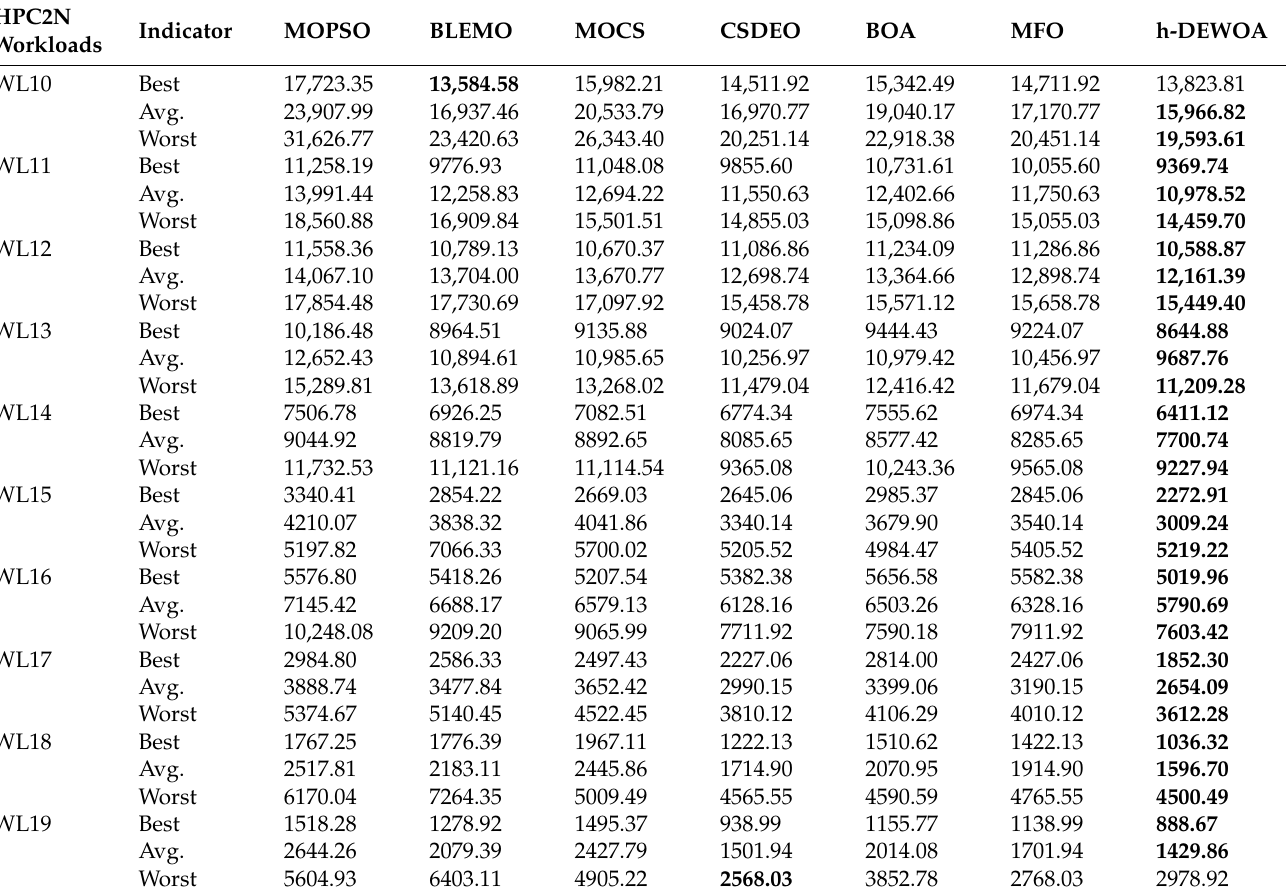
Table 17. Energy consumption statistical results for WL10–WL19